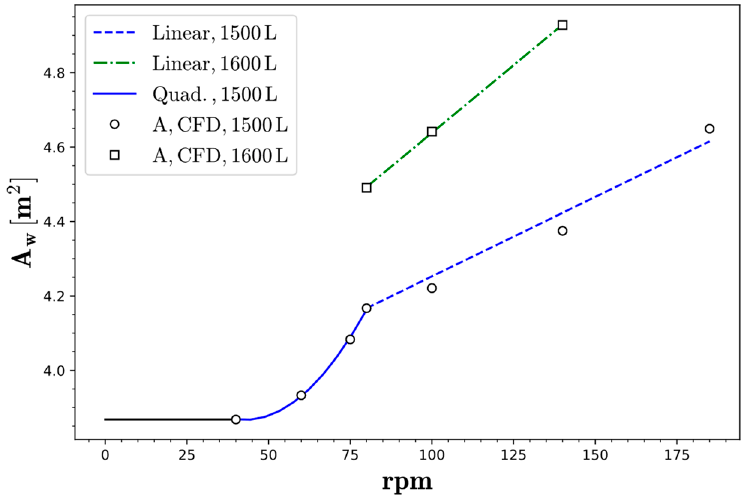
Figure 12. Wetting area (A w ) as a function of the rotational speed for two different liquid volumes. V = 1500 L: 2.130 · 10 − 4 rpm 2 − 0.018 rpm + 4.256 (40 ≤ rpm ≤ 80) and 4.27 · 10 − 3 rpm + 3.825 ( 80 ≥ rpm ≥ 180). V = 1600 L: 7.217 · 10 − 3 rpm + 3.911 (80 ≤ rpm ≤ 140). Note that the linear fitting for V = 1500 L is forced to pass through the first point.